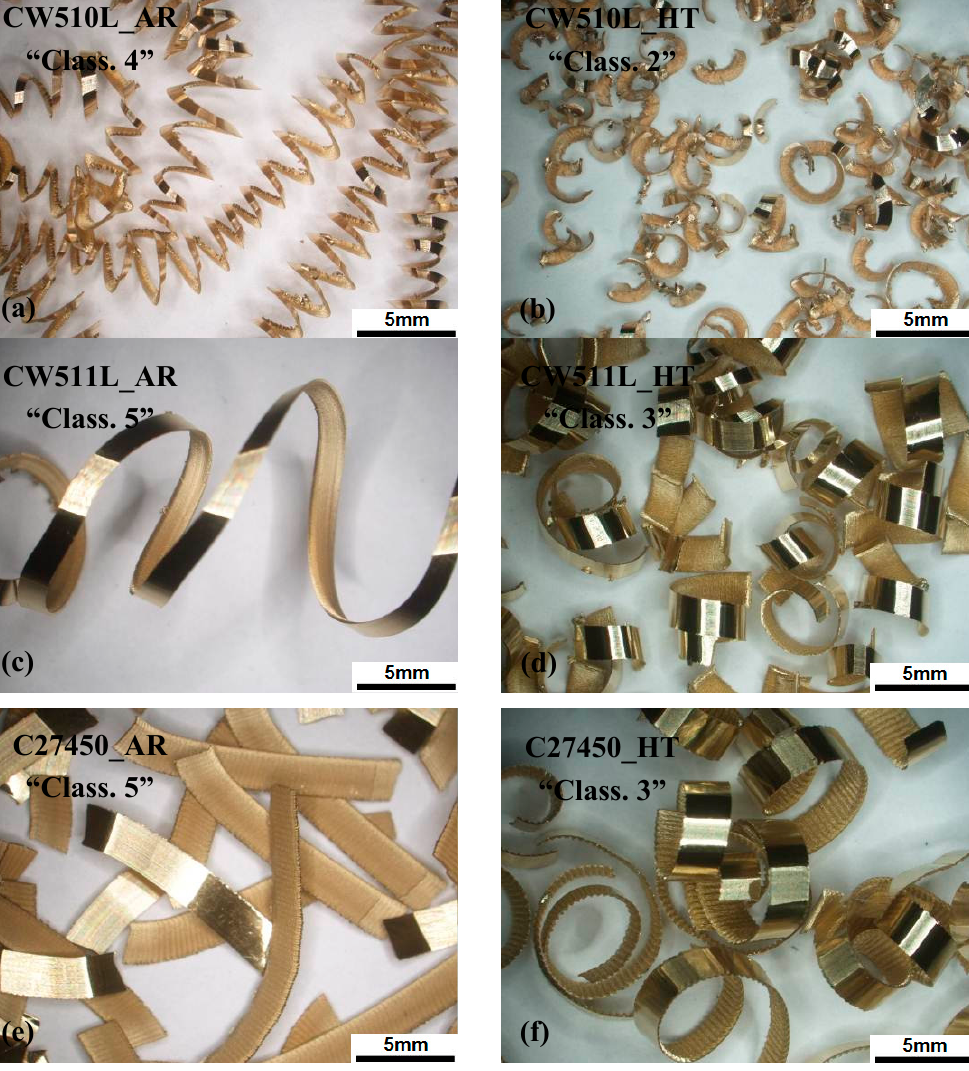
Figure 3. Optimum conditions of chip morphology for the studied alloys after heat treatment (“AR”: as received, “HT”: heat treated). ( a ) CW510L—as received condition, ( b ) CW510L—heat treated